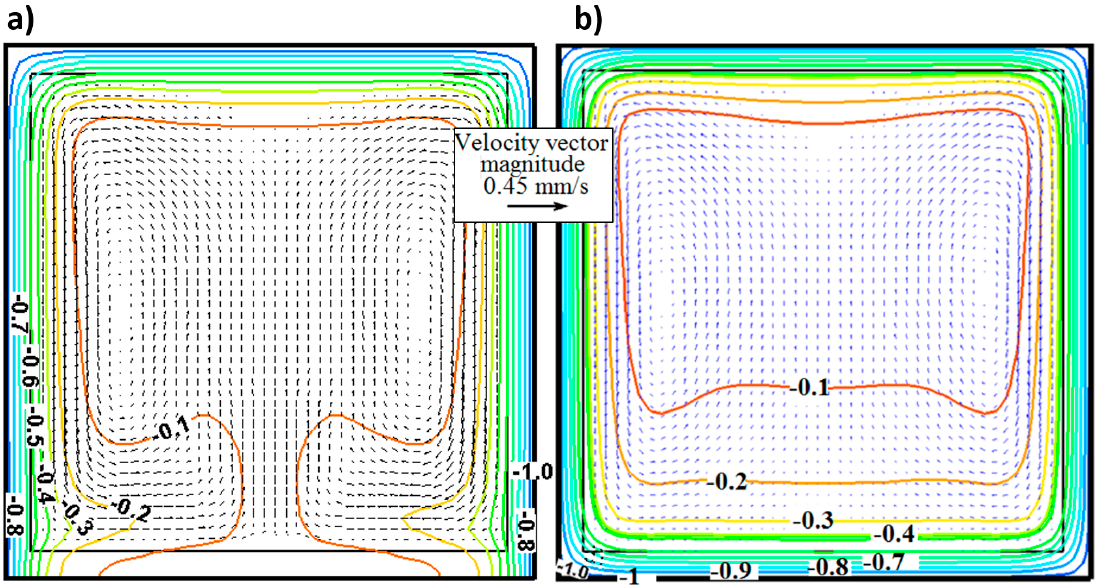
Figure 2. Convection lines and temperature contours after 1785 s for the cases used to validate the mathematical model and numerical procedure proposed in this work with the obtained by [38]. In ( a ) the bottom boundary is adiabatic, while in ( b ) all boundaries have the same non-dimensional temperature.